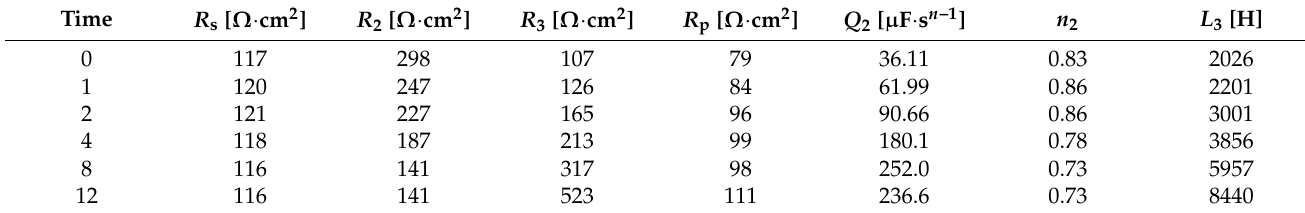
Table 3. Polarization resistance of pure Mg compacted at 100 MPa/400 ◦ C.